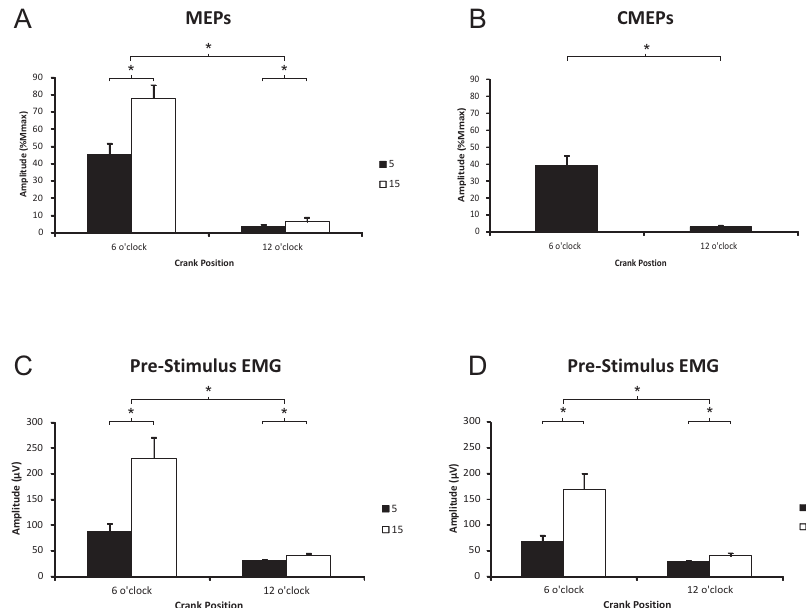
Figure 3. Group data (means ± SE, n = 12) for biceps brachii MEP amplitudes ( A ), and pre-stimulus EMG prior to transcranial magnetic stimulation (TMS; C ). Group data (means ± SE, n = 8) for CMEP amplitudes ( B ) and pre-stimulus of the biceps brachii prior to TMES ( D ). MEP and CMEP amplitudes are expressed relative to the M max taken during cycling at the same cadence and workload. * Significant difference ( p < 0.05). Abbreviations are: MEP, motor evoked potential; EMG, electromyography; TMES, transmastoid electrical stimulation; CMEP, cervicomedullary motor evoked